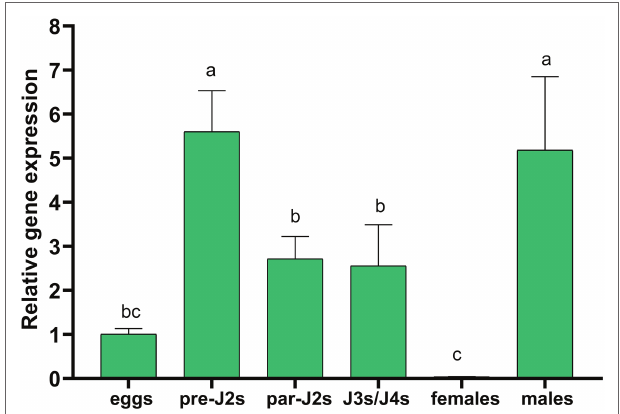
FIGURE 2 | The expression levels of Hg-flp-22 by quantitative real-time (qRT)- PCR analysis in eggs, pre-parasitic J2s (pre-J2s), parasitic J2s (par-J2s), J3s/ J4s, and adult females and males. Gene expressions were calculated by using the 2 −ΔΔ CT method and were presented relative to those of eggs (normalized with an endogenous reference gene Hg-GAPDH ). Values are means ± SD from three biological replicates. Bars with the same letters indicate no significant difference at p > 0.05 (One-way AVOVA, Tukey’s HSD test).